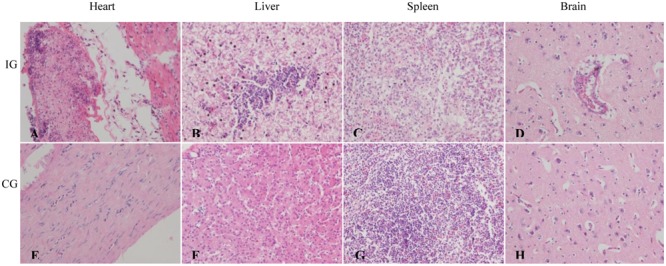
Pathological changes of the APEC-infected ducks. (A) Heart: a large amount of fibrinous exudate, necrosis heterophilic granulocyte and histiocytic cells in the caseous exudate. (B) Liver: diffuse vacuolar degeneration and a lot of necrosis of hepatocyte with lymphocytic infiltration. (C) Spleen: tissue loose, lymphocytic necrosis and heterophilic granulocyte infiltration. (D) Brain: perivascular inflammatory infiltrates. (A–D) Represent the heart, liver, spleen, and brain of ducks from the APEC-infected group, respectively; (E–H) represent the heart, liver, spleen, and brain of ducks from the control group, respectively. Magnification 400×. IG, infection group; CG, control group.